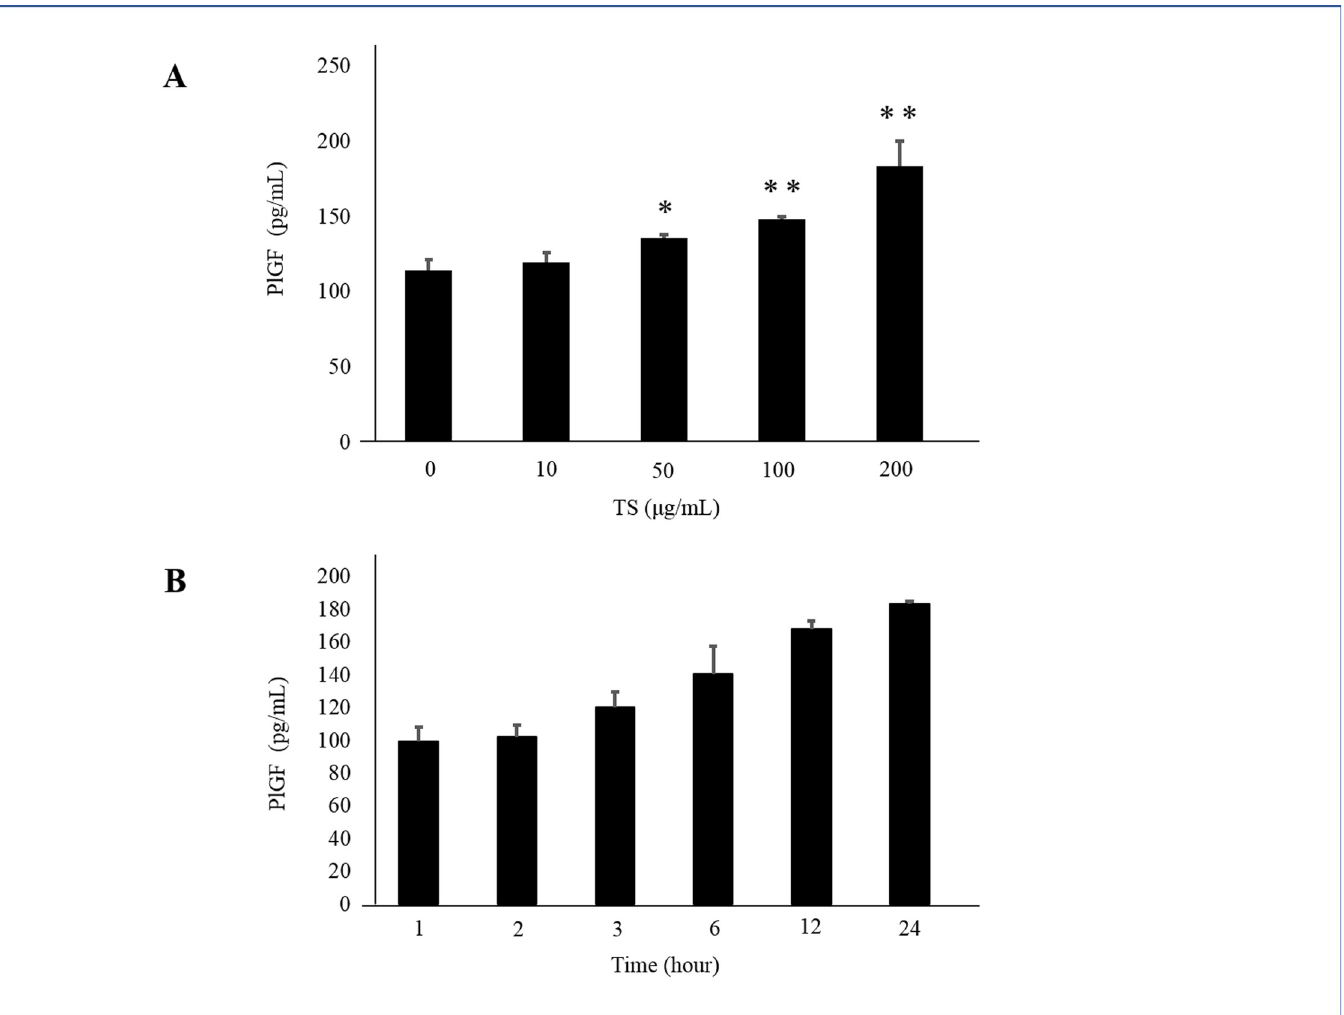
Fig 4. Effect of TS on PlGF expression in HUVECs. A: Dose correlation experiment. B: Time course experiment. � indicates P < 0.05; �� indicates P < 0.01. TS, Tokishakuyakusan; PlGF, placental growth factor; HUVECs, human umbilical vein endothelial cells.